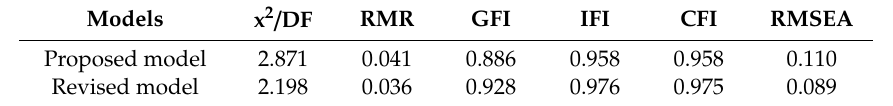
Table 3. Goodness-of-fit indexes in confirmatory factor analysis of proposed and revised